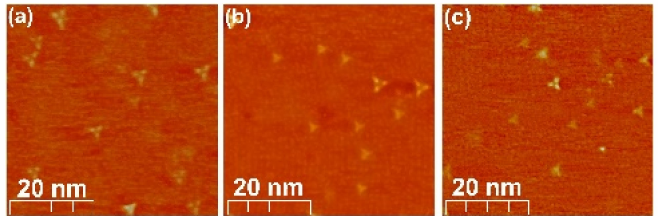
Figure 3. 50 × 50 nm STM topography scans of ( a ) Bi 2 Se 3 , ( b ) Bi 1.96 Mg 0.04 Se 3 , ( c ) Bi 1.98 Fe 0.02 Se 3 , revealing the density of the defects on the studied surfaces (obtained at V bias = − 340 mV and I = 300